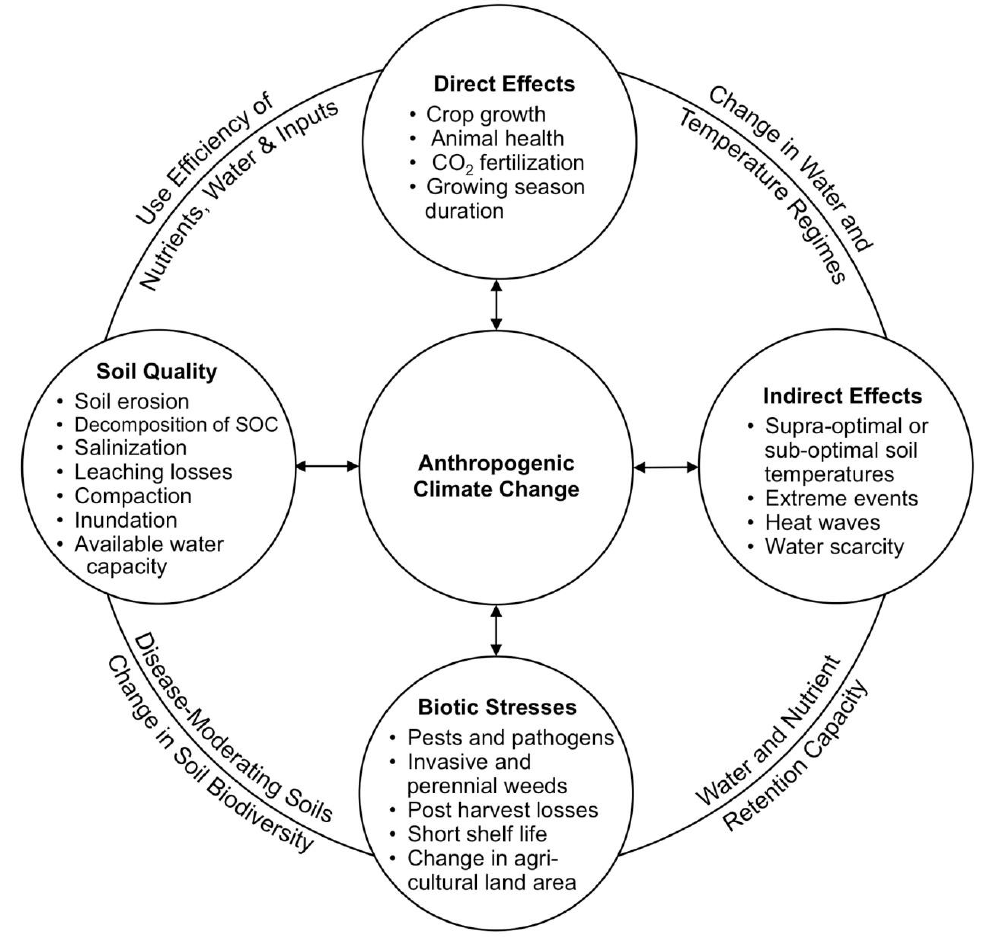
Figure 1. Direct and indirect effects of human-induced climate change on food security, which can be negative or positive, depending on the biome and regional characteristics.